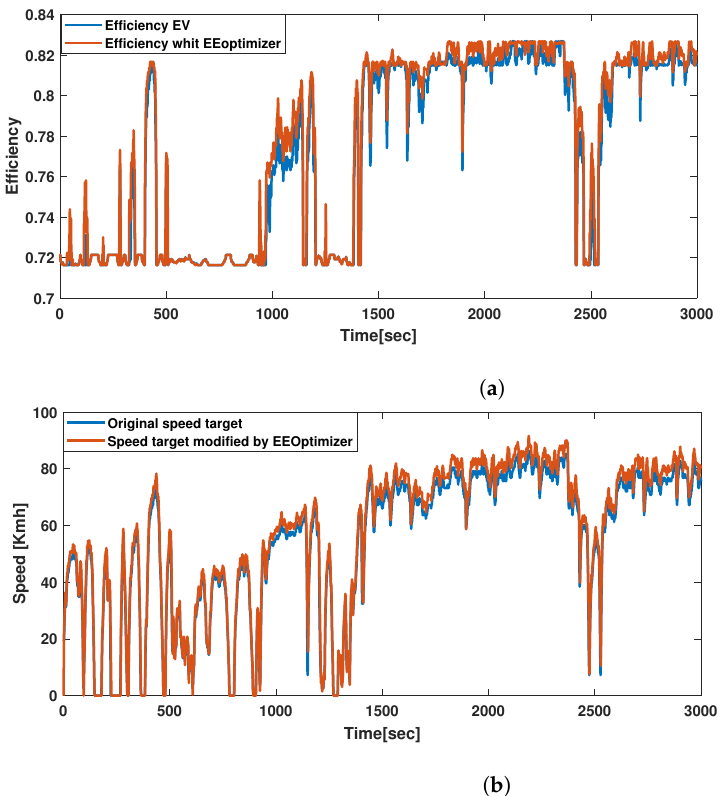
Figure 15. Comparison of the original and optimal values for δ = 5%: ( a ) Efficiency; ( b )